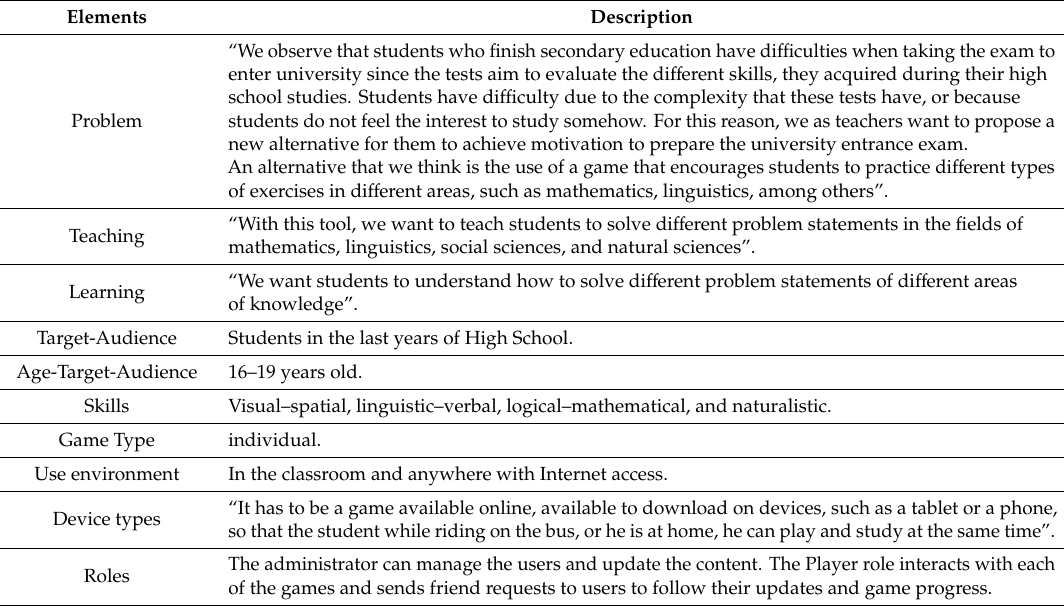
Table 3. Main elements collected in the interview